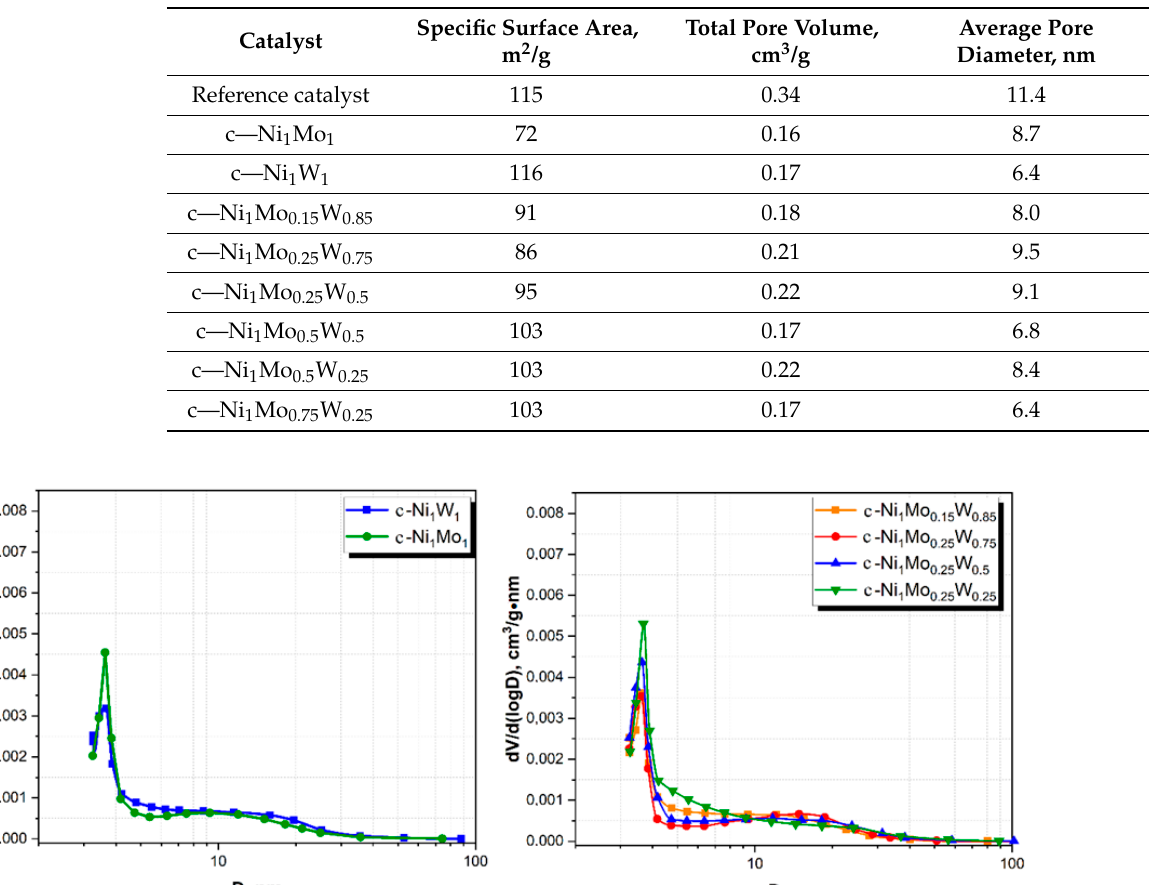
Table 2. Textural properties of the catalysts.